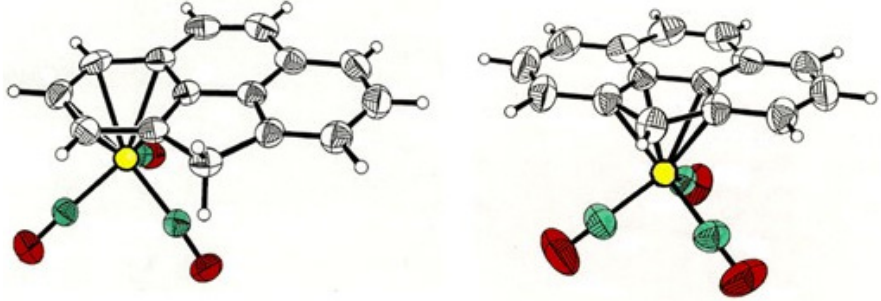
6 -cppH)Cr(CO) η 5 -cpp)Mn(CO) 3 and ( right ) ( 3